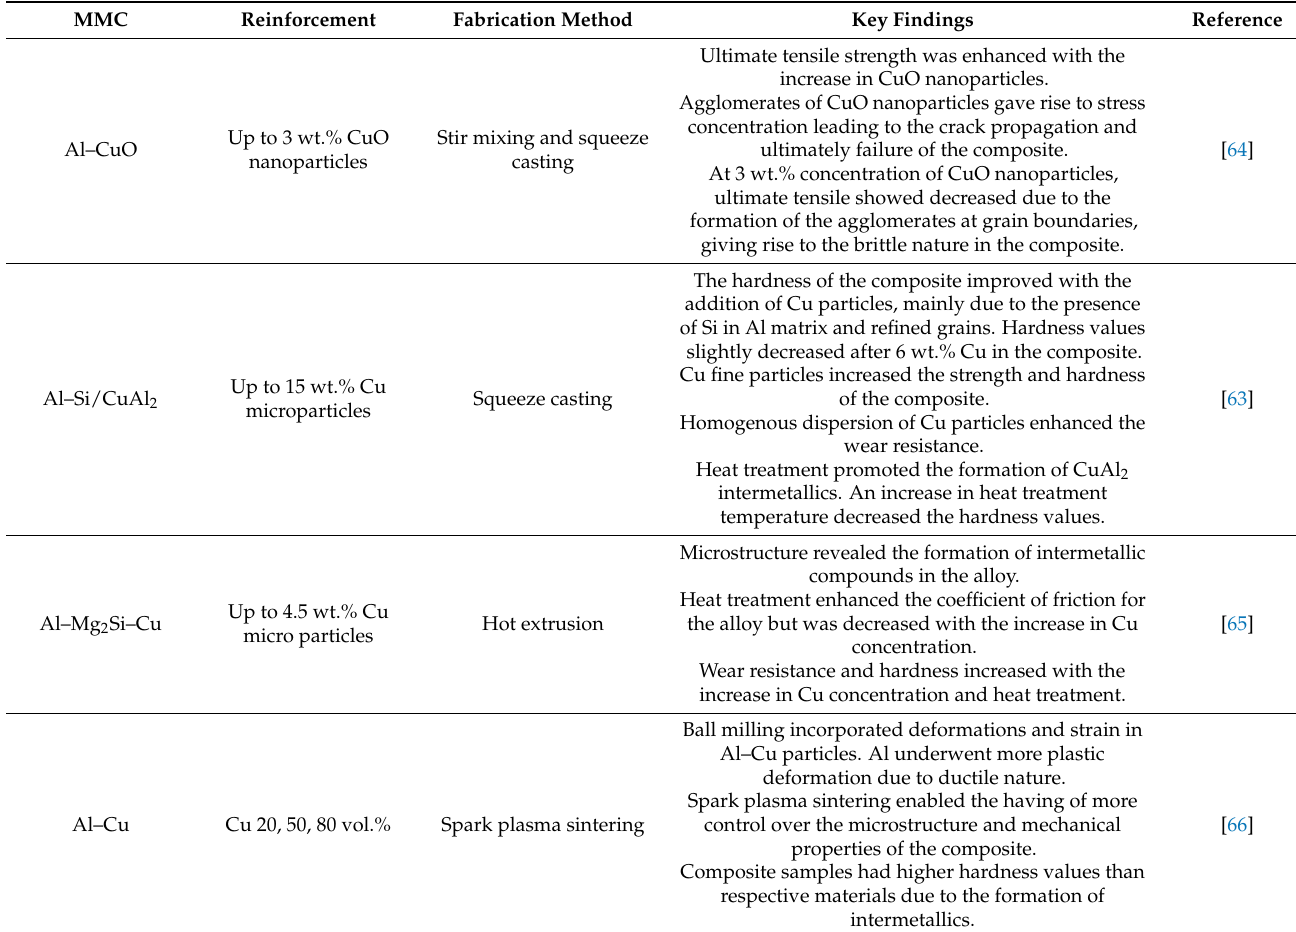
Table 7. The key findings and fabrication methods of Cu- and Al-based composites.